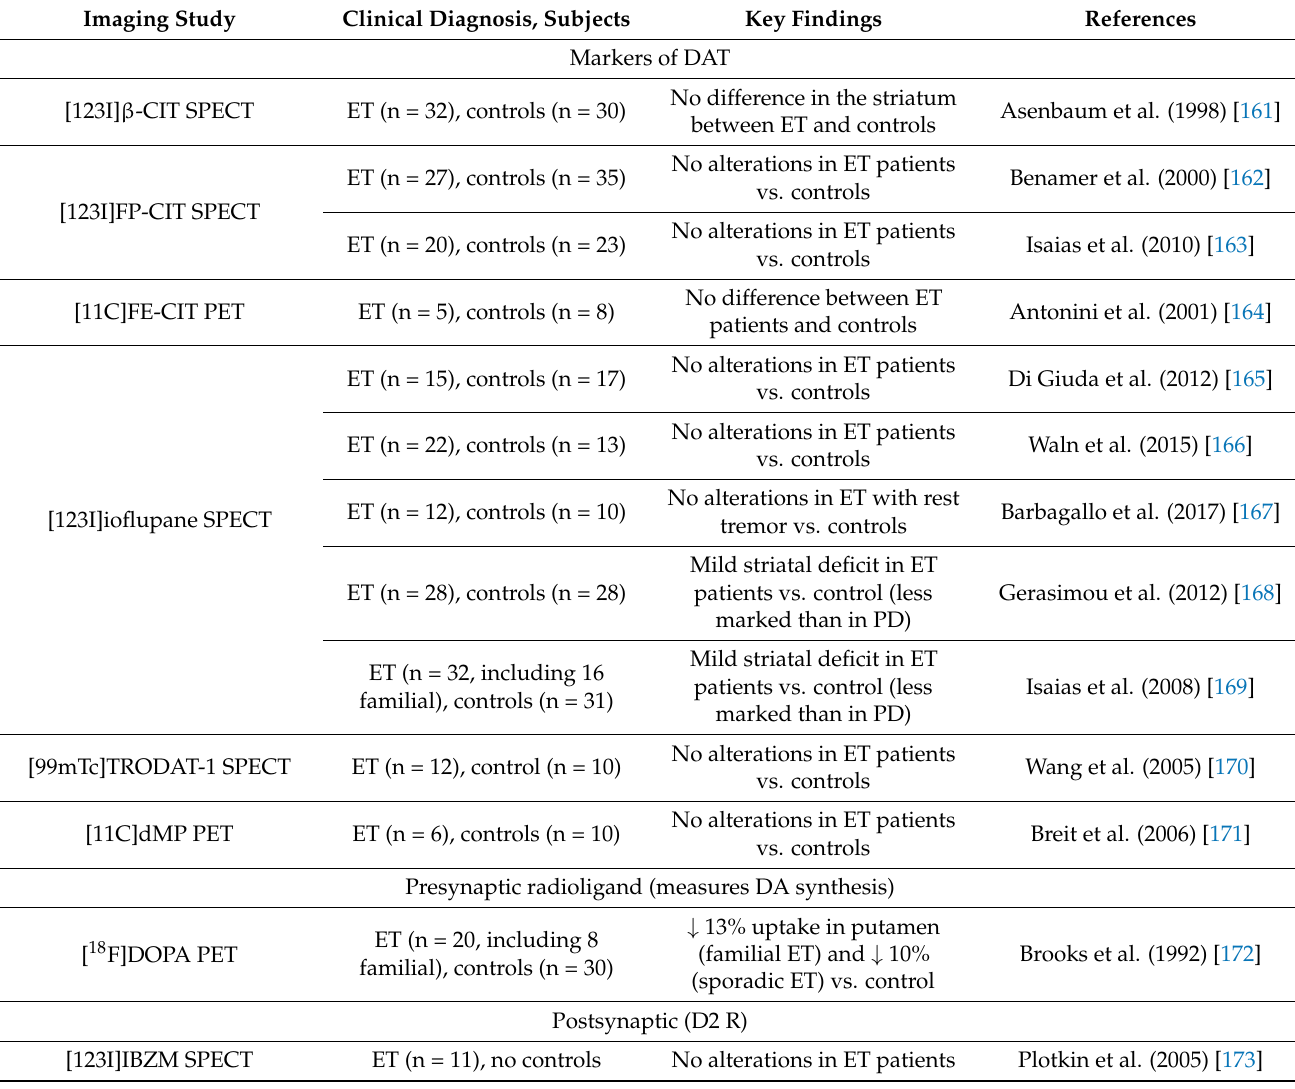
Table 2. Examples of imaging studies with markers of dopaminergic system in patients with ET. Imaging Study Clinical Diagnosis, Subjects Key